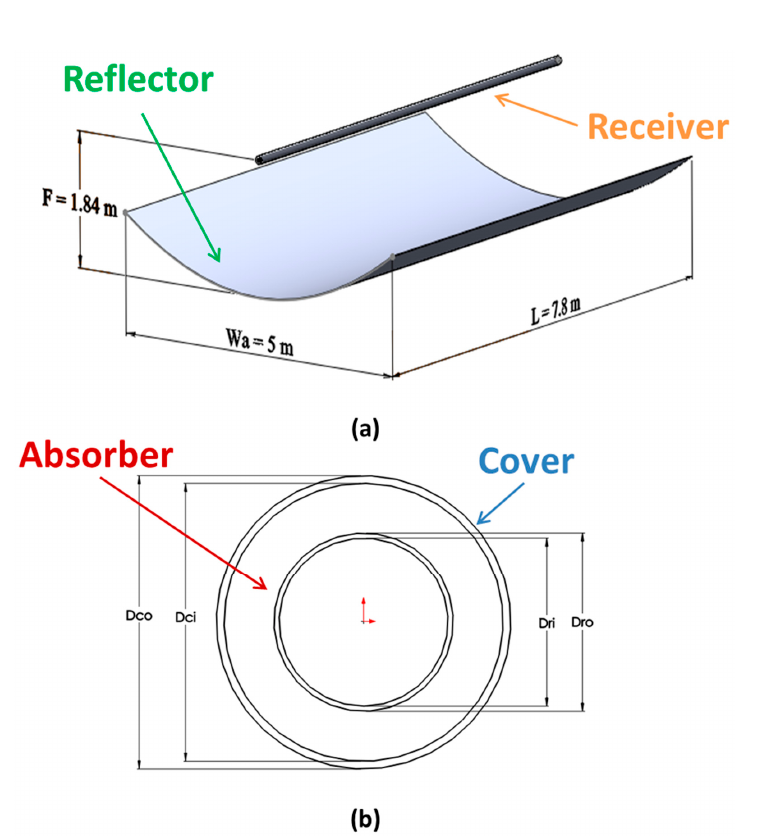
Figure 1. ( a ) The examined module of the present analysis. ( b ) The main dimensions of the receiver.